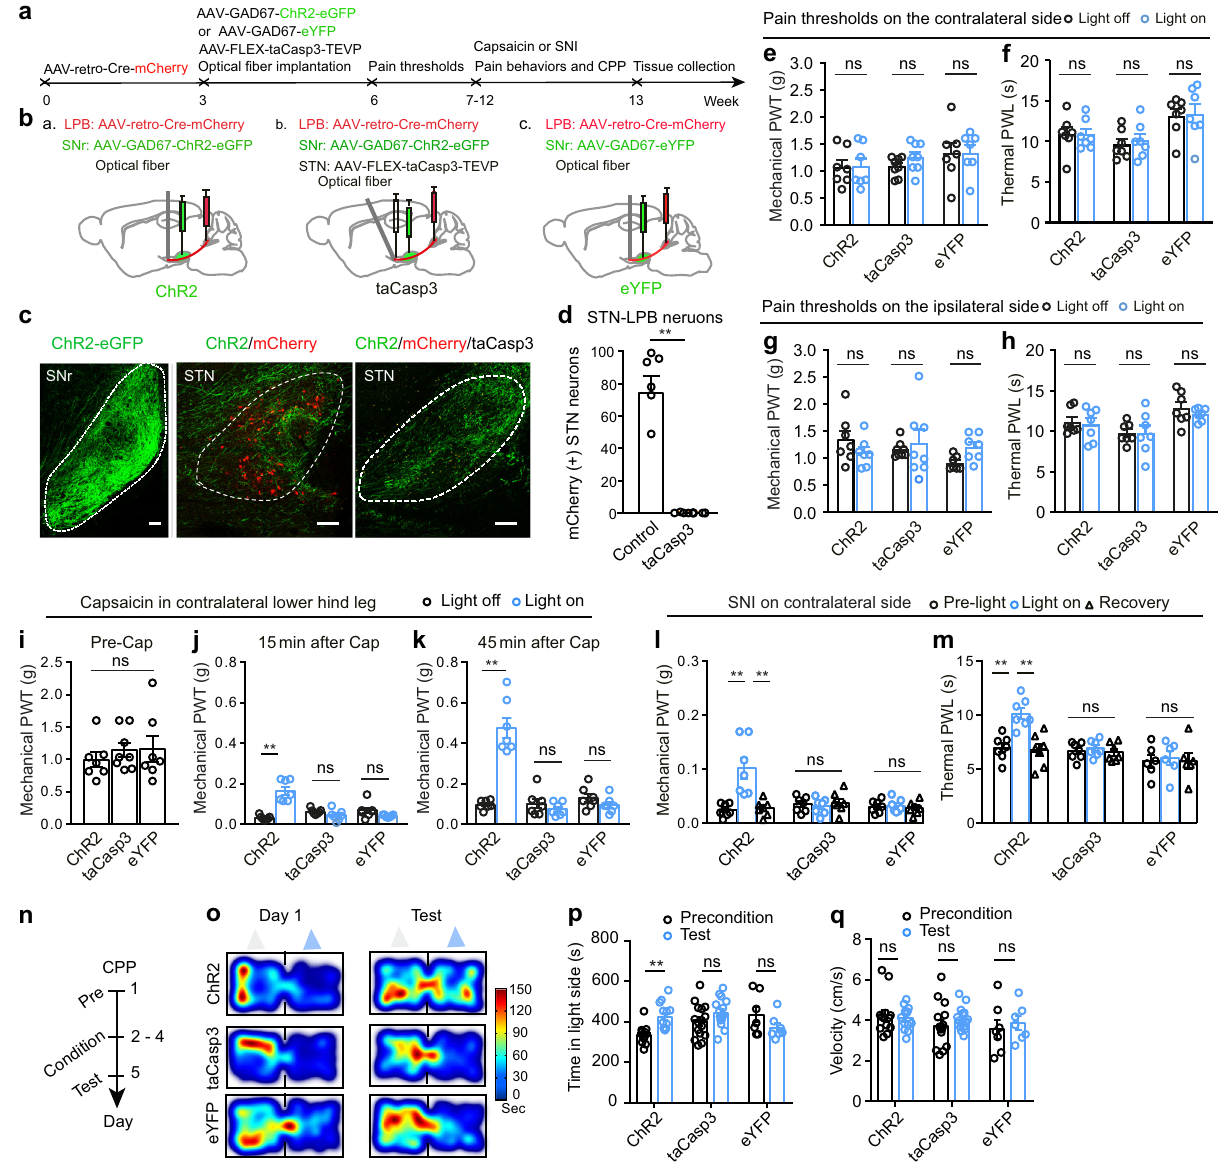
Fig. 10 | The SNr GABA -STN Glu -LPB Glu pathway in pain-likebehaviors.a , b Timeline and diagram of experimental setup. c Example images of ChR2-expression in the SNr (left), mCherry-labeled STN – LPB neurons surrounded by ChR2- labeled SNr GABA terminals (middle), and ChR2-labeled SNr GABA terminal in the STN with ablation of STN – LPB neurons (right). d Quanti fi cation of the loss of STN – LPB neurons ( t = 7.28, P = 0.0003, n = 6 per group). e – h Effect of dis- ruption of the SNr – STN – LPB pathway on PWT and PWL on both hind paws. e F (1, 19) = 0.56, P = 0.58. f F (1, 19) = 0.087, P = 0.92. g F (2, 19) = 2.44, P = 0.11. h F (2, 19) = 0.18, P = 0.84. n ≥ 7 per group. i Baseline PWT in the three groups ( F (2, 19) = 0.42, P = 0.66; n ≥ 7 per group). j – m Effect of ablation of STN – LPB neurons on the pain-relieving effects of activation of the SNr – STN projection